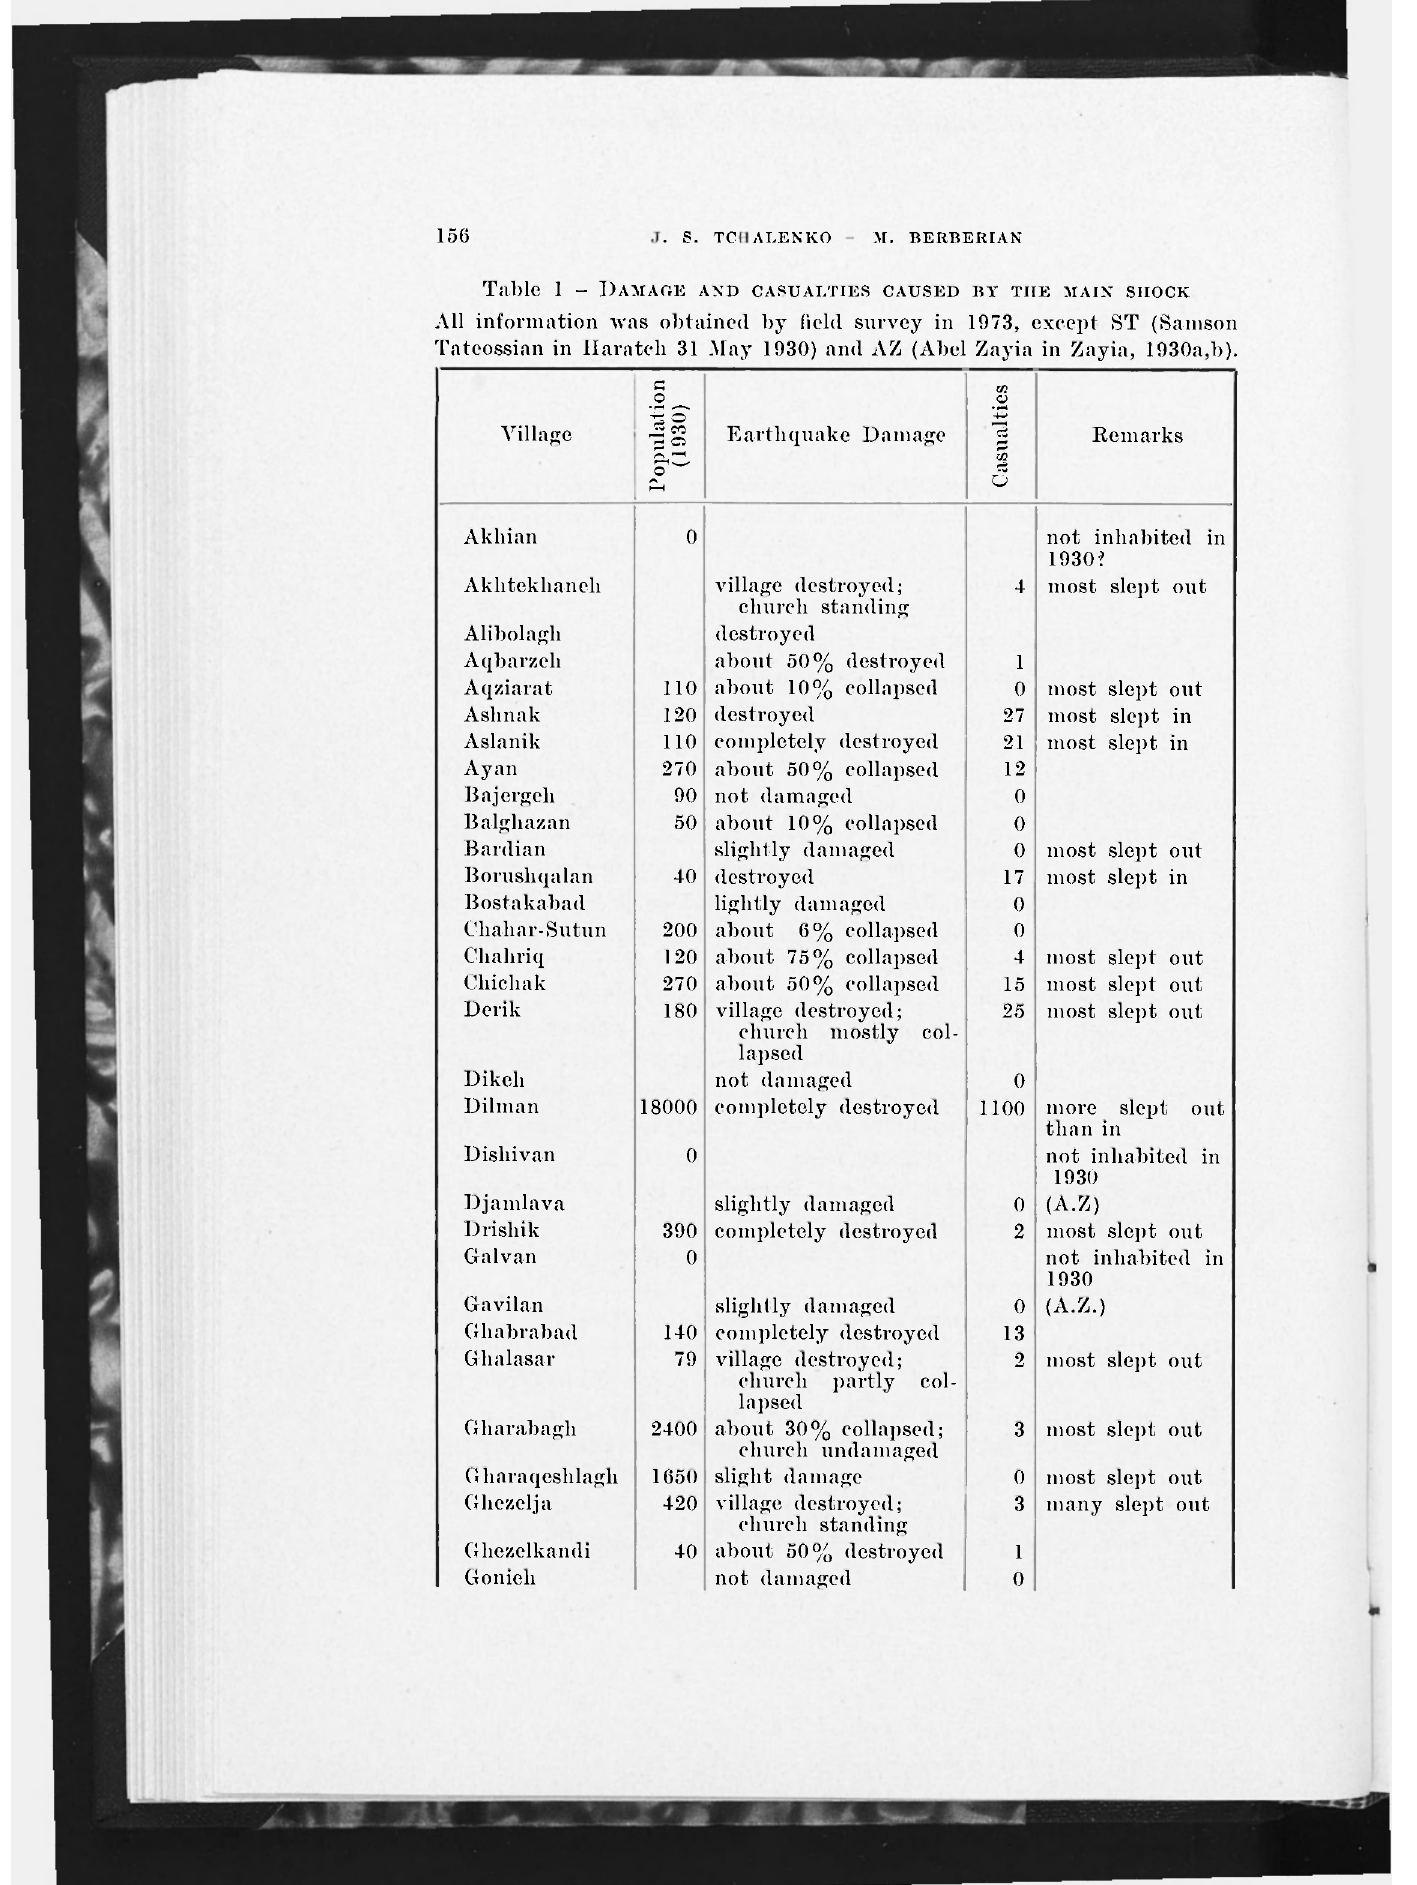
Table 1 - DAMAGE AND CASUALTIES CAUSED BY TIIE MAIN